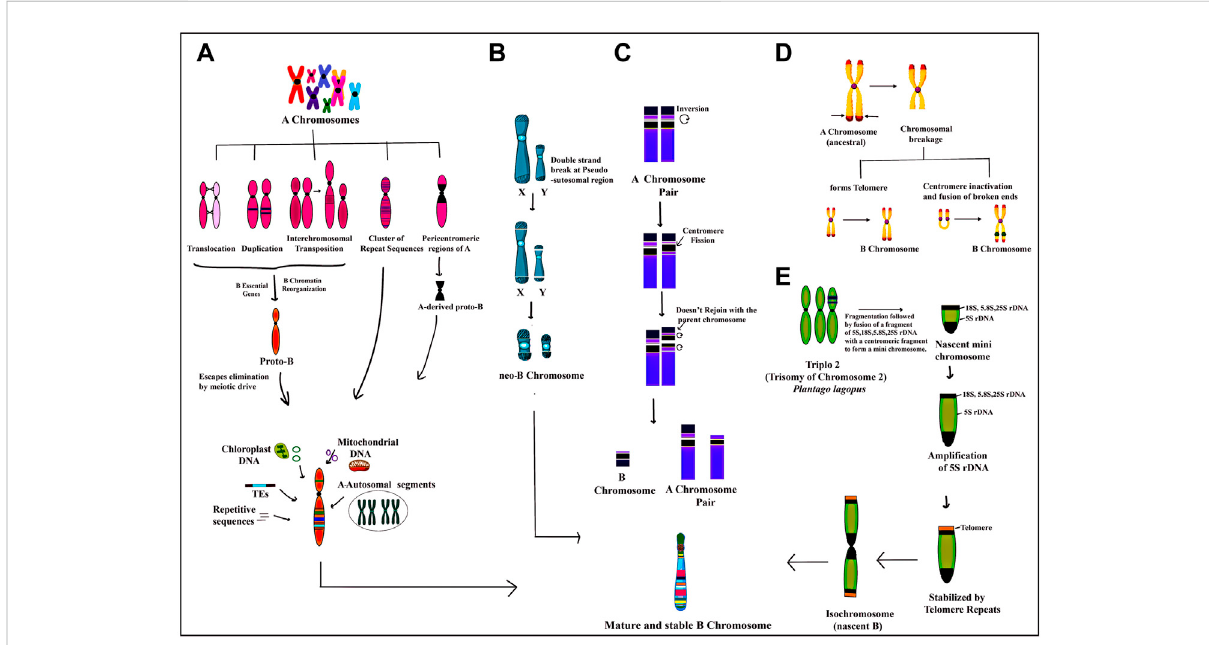
FIGURE 1 Depiction of various proposed models on the origin of B chromosomes: (A) genomic DNA amalgamated from multiple A chromosomes undergo structural rearrangements like translocation, duplication, transposition, insertion of repeat sequences and pericentromeric regions followed by the addition of a few B essential genes required for their successful transmission and chromatin reorganizing genes resulting in the formationofanascentProto-Bchromosome.TheProto-Bchromosomeisfurthermodi fi edbytheadditionoftransposableelementsandDNA sequences from the organellar genome and ampliconic multiple A chromosome sequences to form a mature stable B chromosome with diverse functions. (B) the pseudoautosomal region (PAR) on X and Y chromosomes undergoes double-stranded breaks which in association with